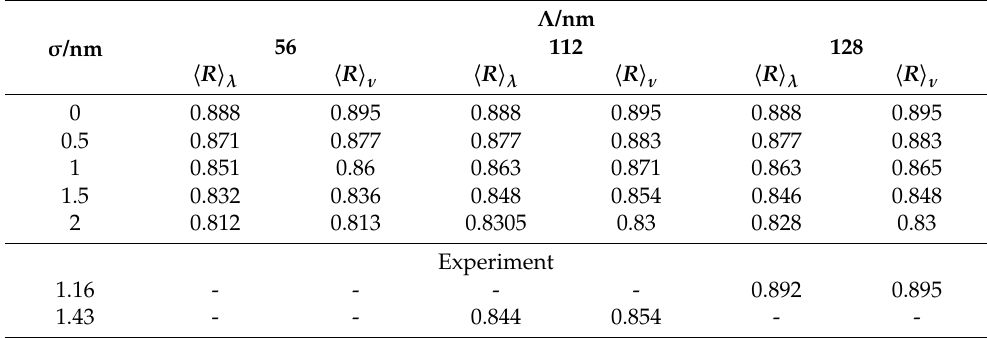
Table 5. Averaged reflectances for protected (i.e., MgF 2 -coated) aluminum surfaces for simulated lateral periods Λ and roughnesses σ and available experimental